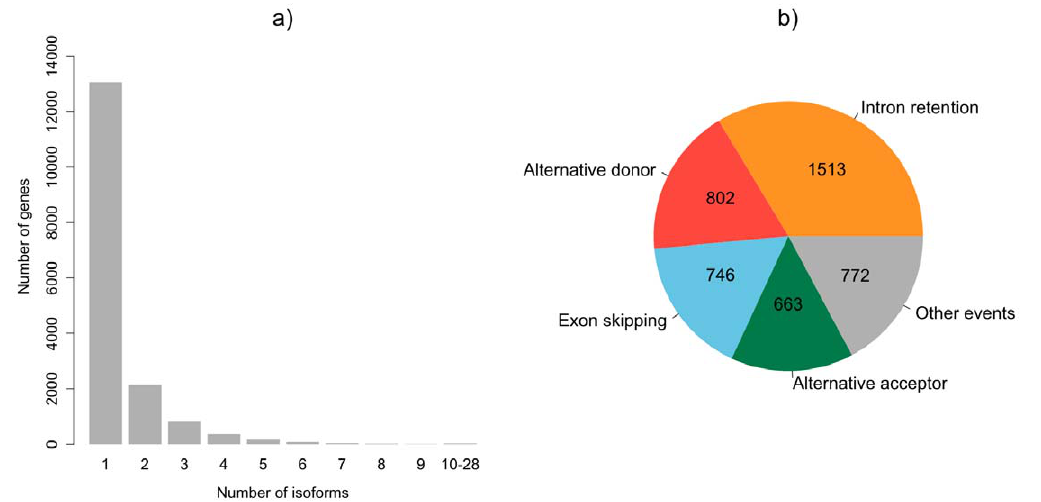
Figure 4. Alternative splicing in D.pseudoobscura . a) Distribution of number of isoforms per gene, b) Distribution of alternative splicing modes.